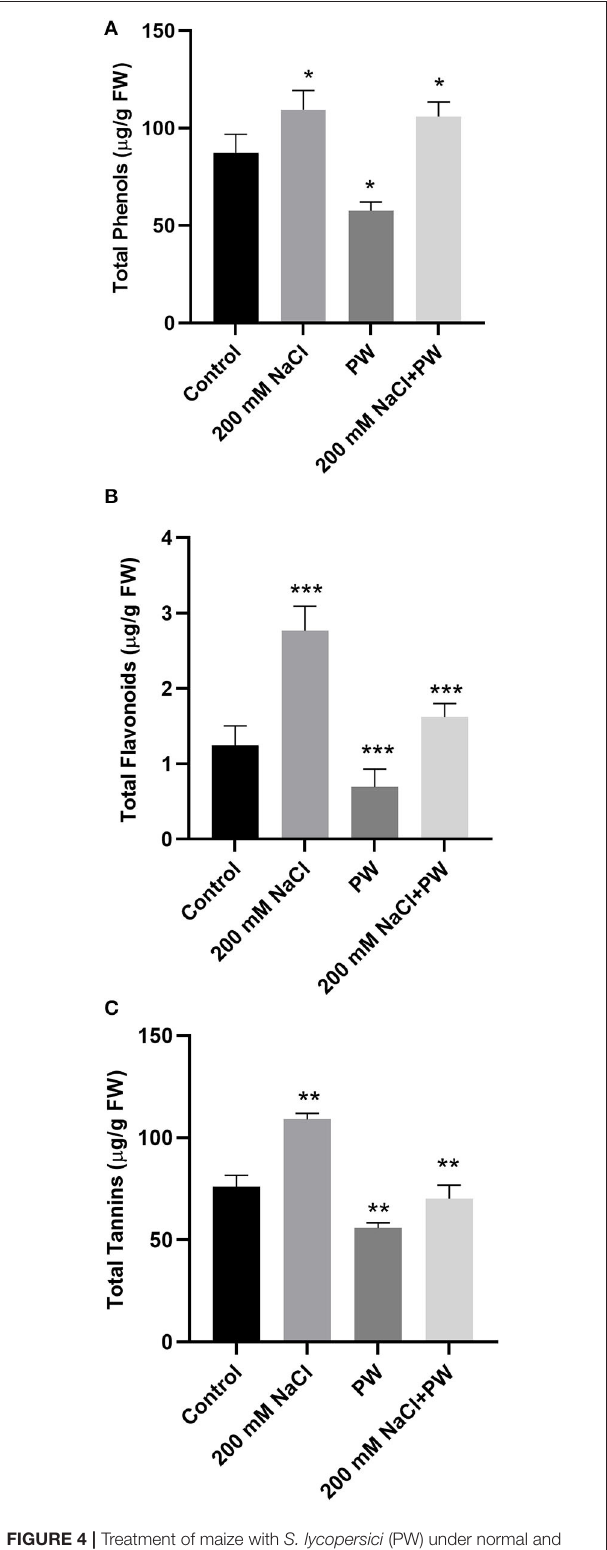
FIGURE 4 | Treatment of maize with S. lycopersici (PW) under normal and salt-stressed conditions. (A) Total phenols, (B) flavonoids, and (C) tannins. Bars indicate mean ± standard error from three replicates at a significant level of p ≤ 0.05. FW, fresh